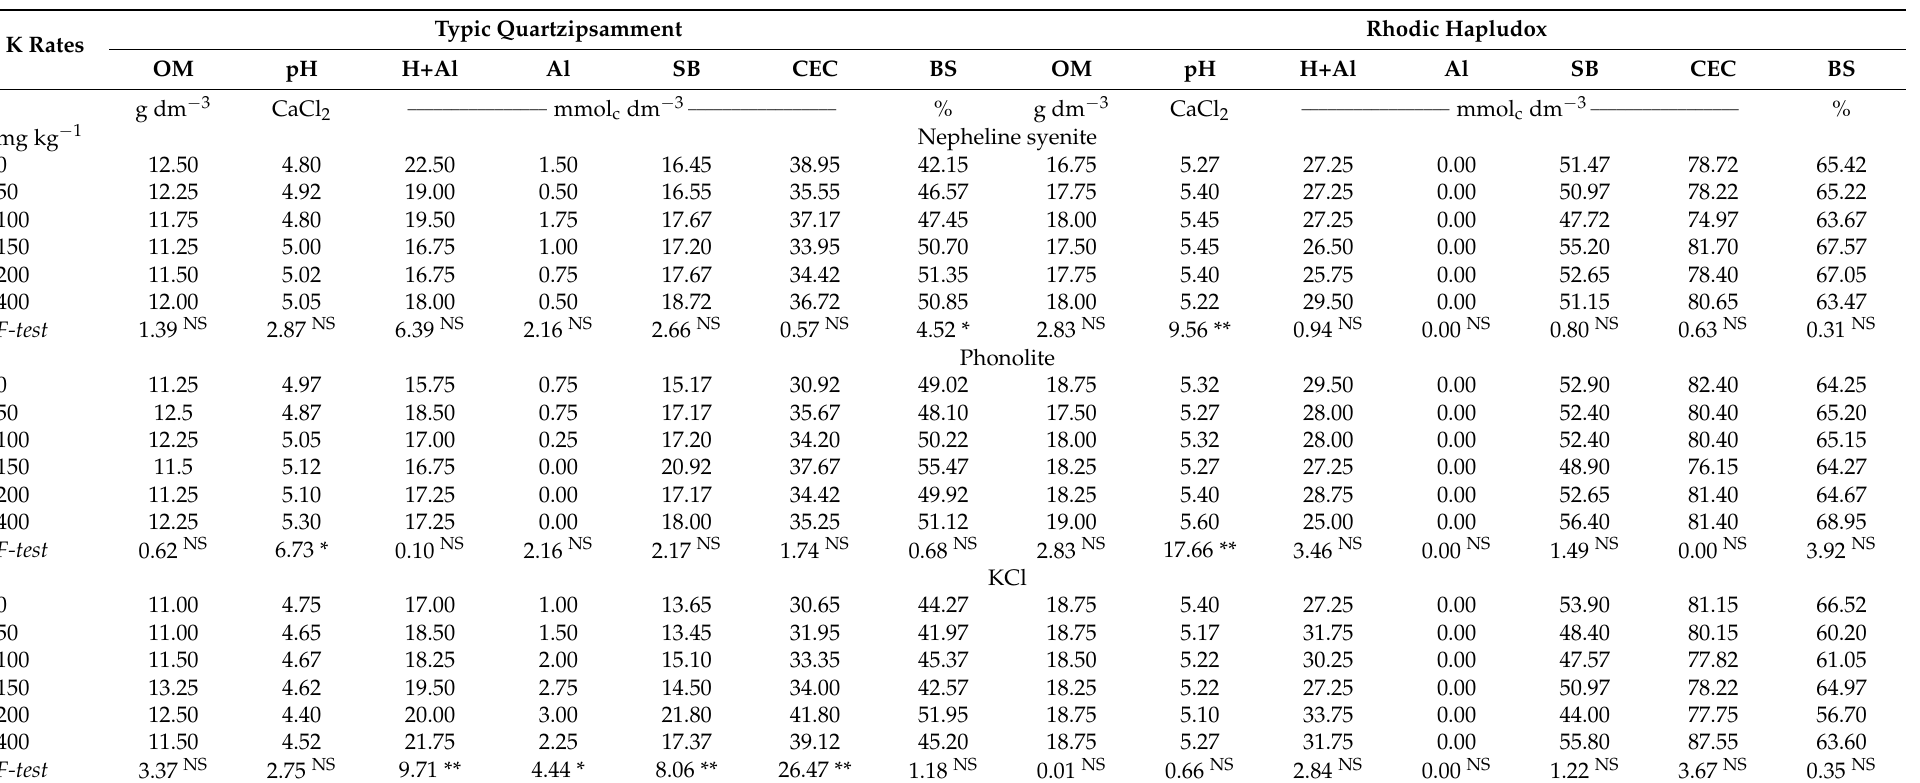
Table 4. Chemical attributes of a Typic Quartzipsamment and a Rhodic Hapludox after maize cultivation, depending on the rates and sources of